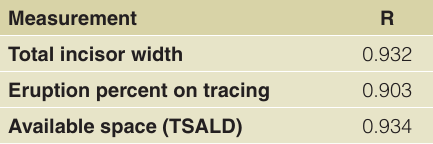
Table 1. Pearson correlation coefficients for measurements obtained by the two assessors.